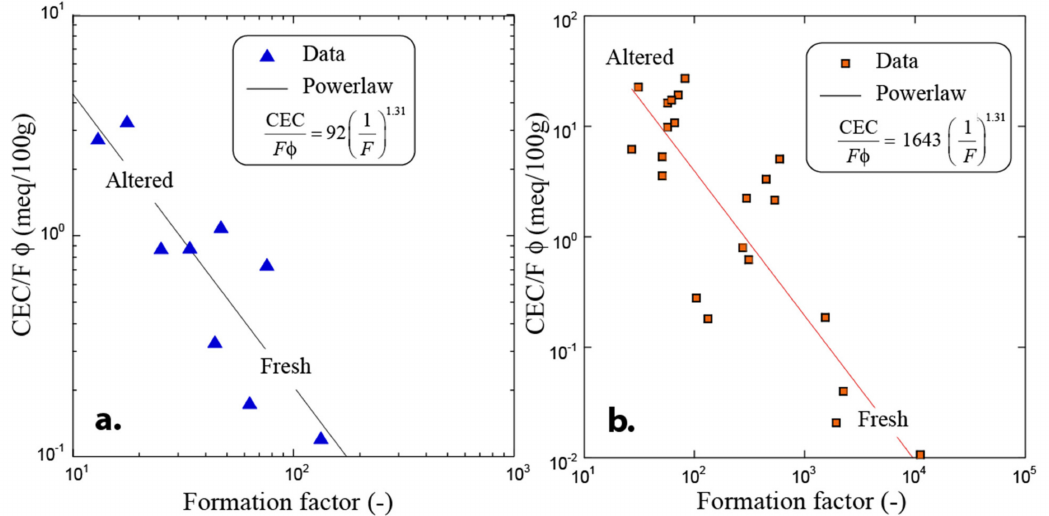
Figure 22. Alteration trend. ( a ) Alteration trend for (kaolinite-rich) stratovolcanoes. Reduced cation exchange capacity versus intrinsic formation factor. This trend is not predicted by the theory and can be seen as an additional relationship showing an alteration trend from fresh to altered core samples. Core samples from la Soufri è re strato-volcano. ( b ) Alteration trend for (smectite-rich) shield volcanoes (Hawaii). Reduced cation exchange capacity versus intrinsic formation factor. This trend is not predicted by the induced polarization theory and can be seen as an additional relationship showing an alteration trend from fresh to altered core samples. Core samples from